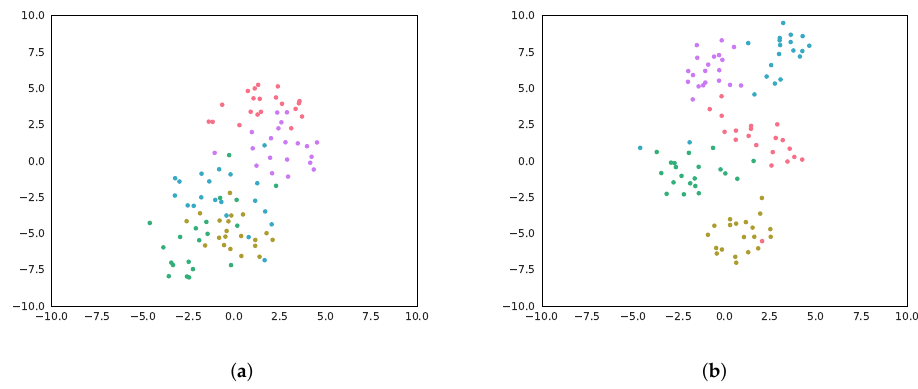
Figure 6. The t-SNE visualization. We use t-SNE to perform visual analysis on the extracted novel data features and the reconstructed features. ( a ) shows t-SNE result on novel data features, and ( b ) shows t-SNE result on reconstructed